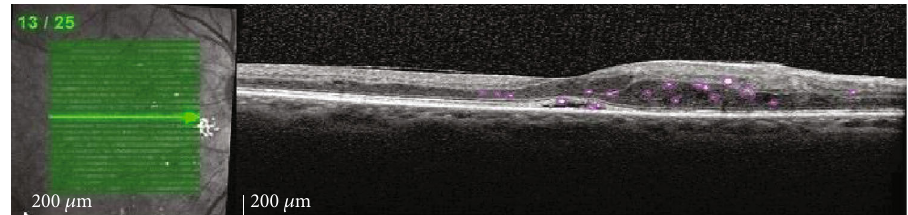
Figure 3: Highlighted OCT image revealing the small HF.